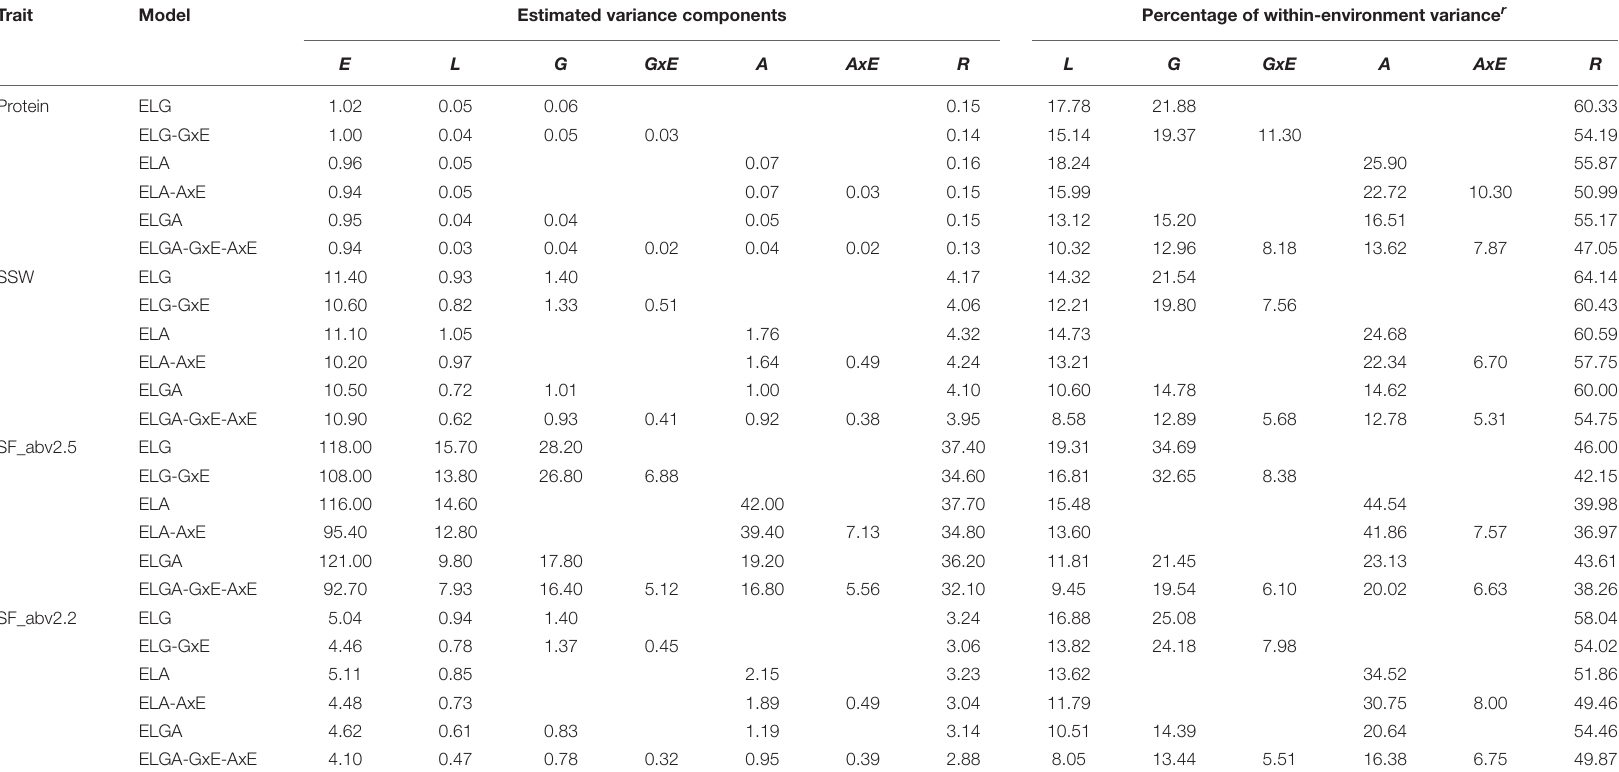
TABLE 3B | Variance components and percentage within-environment variance for random effects in the models with SJ data. Trait Model Estimated variance components